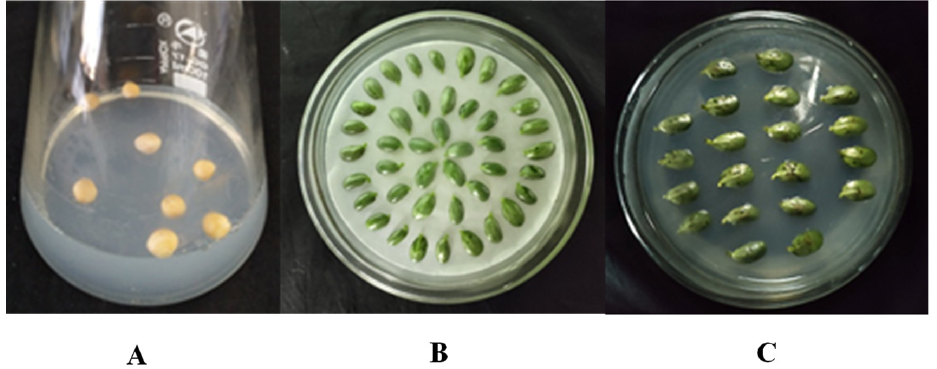
Figure 3. Process of hairy root formation induced by Agrobacterium rhizogenes K599 in soybean cotyledon nodes. ( A ) Germination. ( B ) Co-cultivation. ( C ) Hairy root induction.